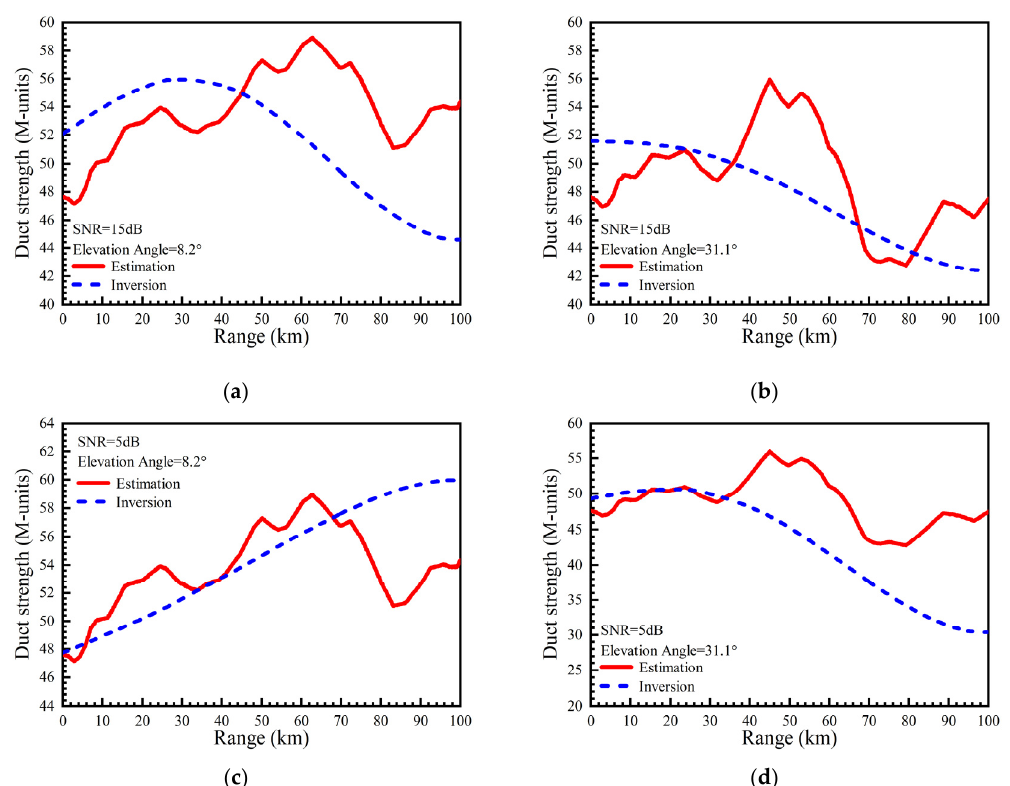
Figure 19. The estimated and inverted duct strength at different satellite elevation angle and SNR cases: ( a ) the satellite elevation angle is 8.2° and the SNR is 15 dB; ( b ) the satellite elevation angle is 31.1° and the SNR is 15 dB; ( c ) the satellite elevation angle is 8.2° and the SNR is 5 dB; and ( d ) the satellite elevation angle is 31.1° and the SNR is 5 dB.